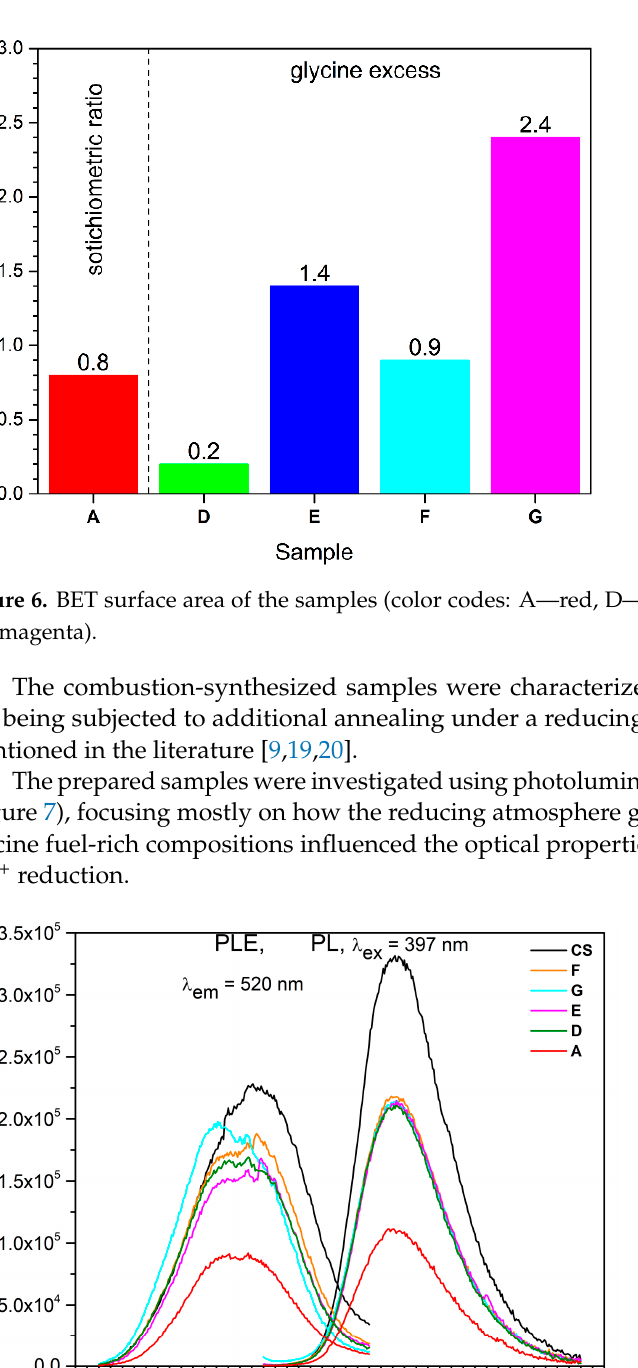
Figure 5. X-ray diffraction patterns of the obtained samples (A, D–G) and commercial sample (CS) samples (color codes: CS—red, A—black, D—blue, E—turquoise, F—magenta, G—green).